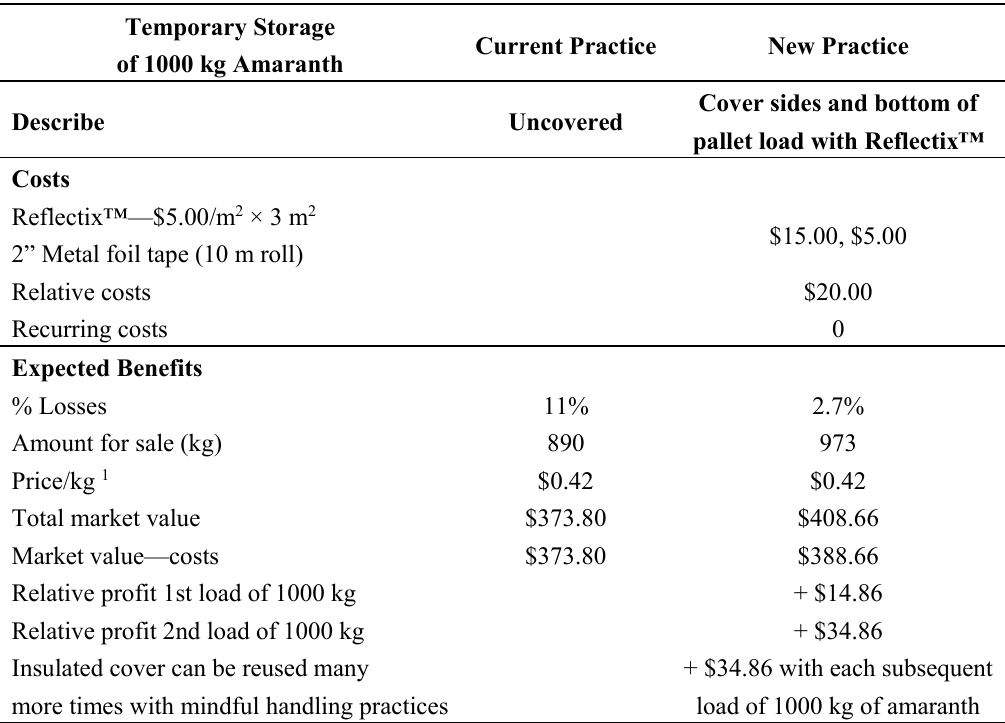
holding period prior to